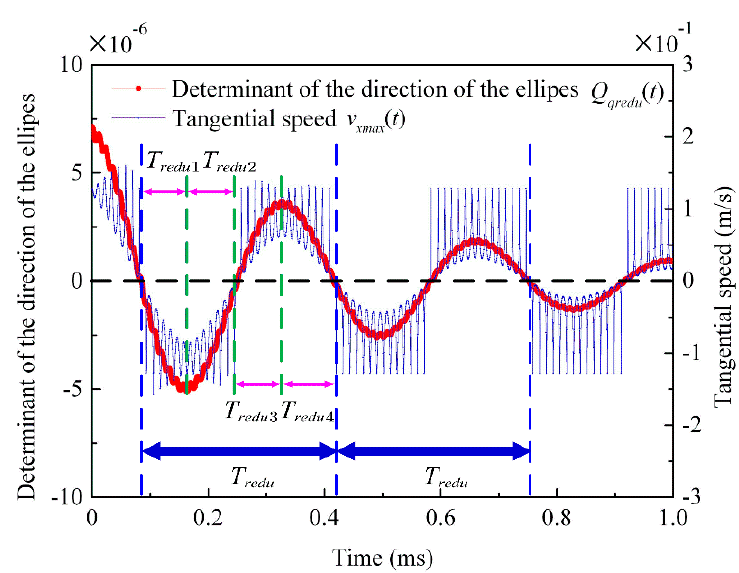
Figure 11. Variation curve of the determining factor equation for the elliptical motion direction.